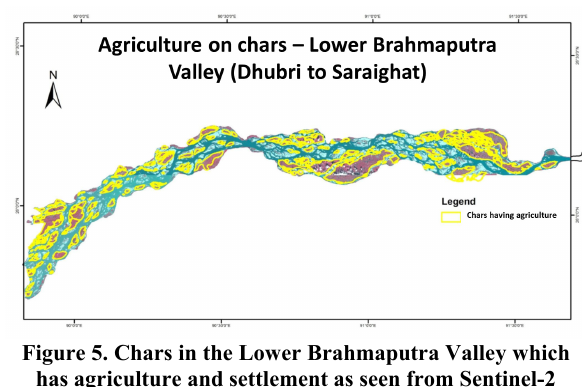
Figure 5. Chars in the Lower Brahmaputra Valley which has agriculture and settlement as seen from Sentinel-2